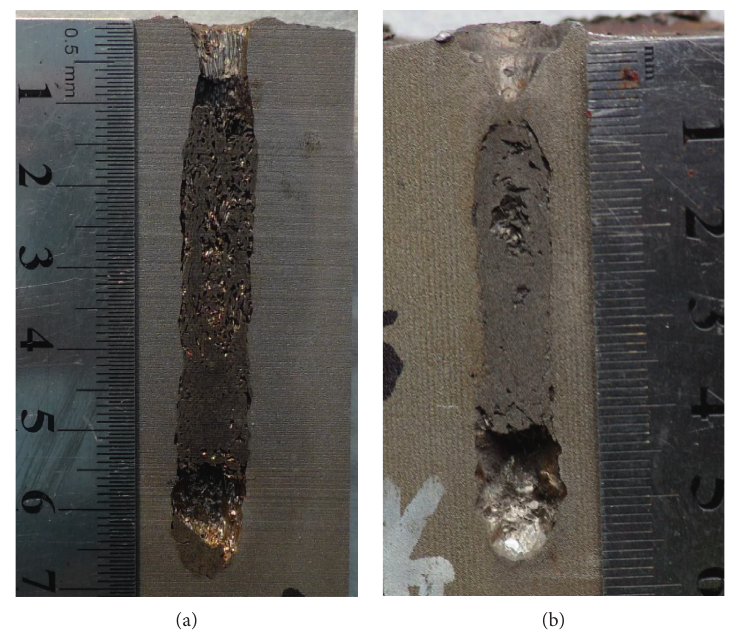
Figure 7: Craters of high-density WF/Zr-MG composite (a) and 93W alloy penetrators (b).